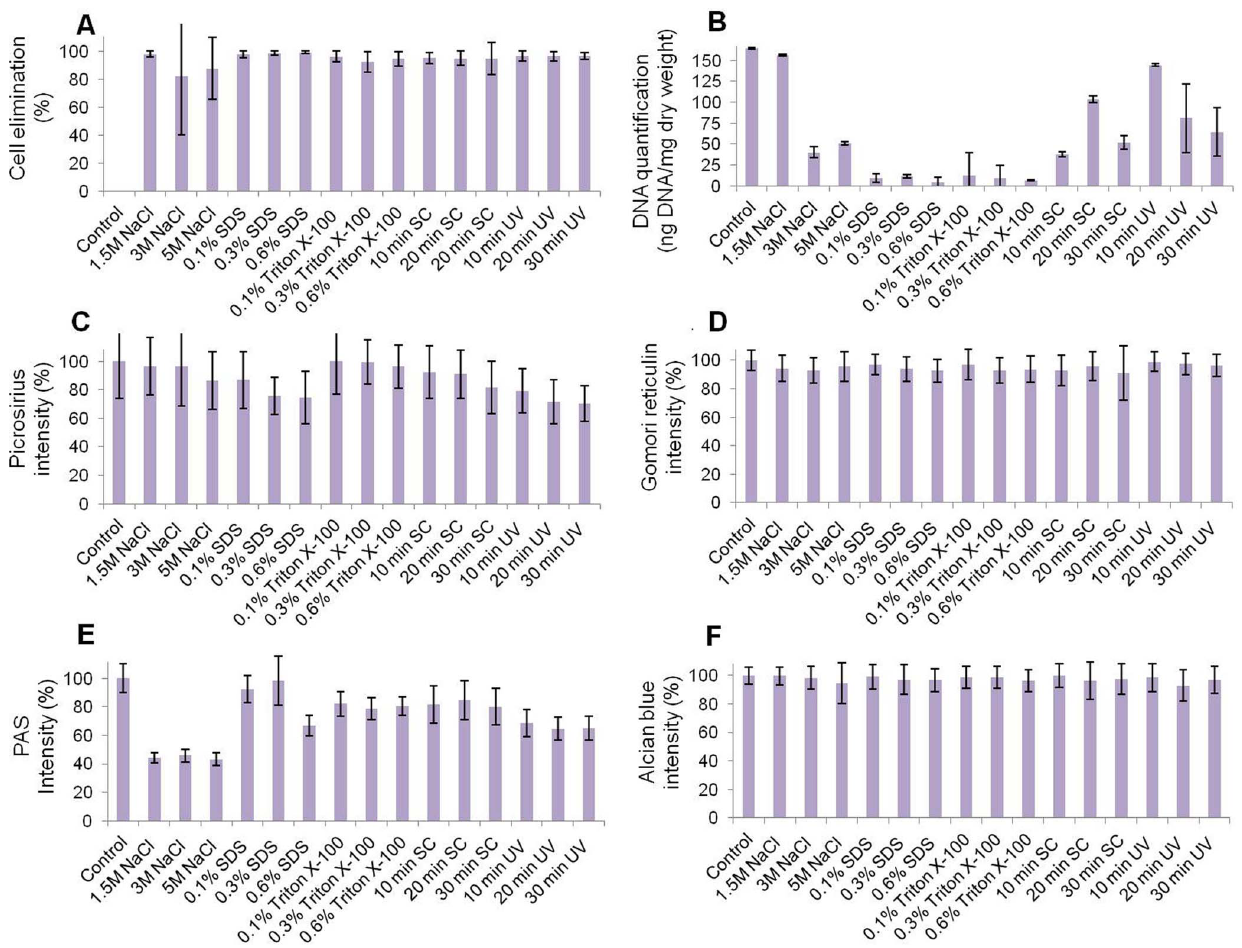
Figure 1. Histograms representing the efficiency of cell removal and tissue structure preservation as determined by DAPI (A), residual DNA quantification (B), picrosirius collagen staining (C), Gomori reticulin (D), PAS glycoprotein staining (E) and alcian blue proteoglycan staining (F). Bars correspond to average values 6 standard deviations.